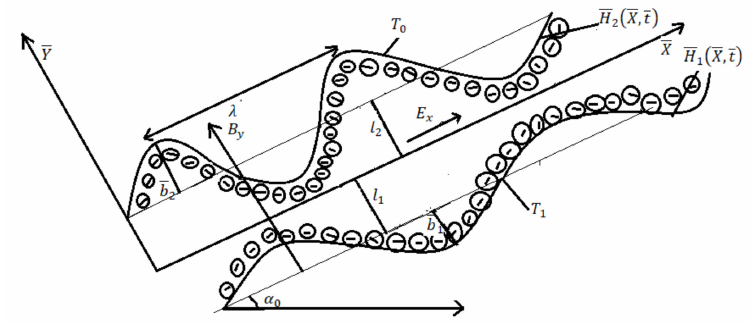
Figure 1. Geometry of the flow